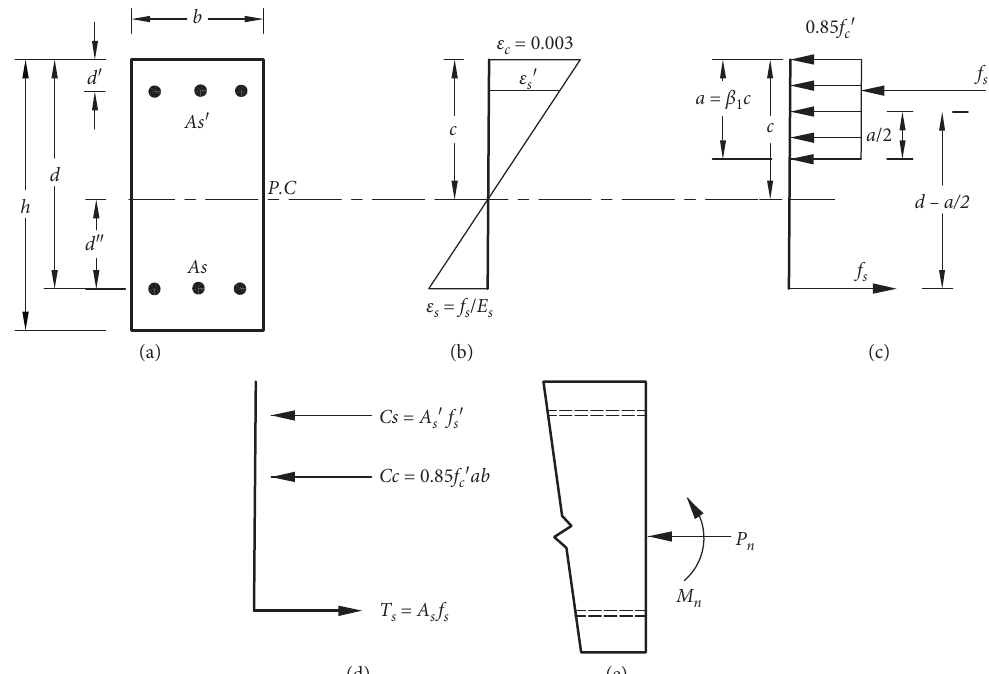
Figure 5: Calculation of Pn and Mn for a given strain distribution. (a) Section. (b) Strain. (c) Stress. (d) Internal forces. (e) Resultant